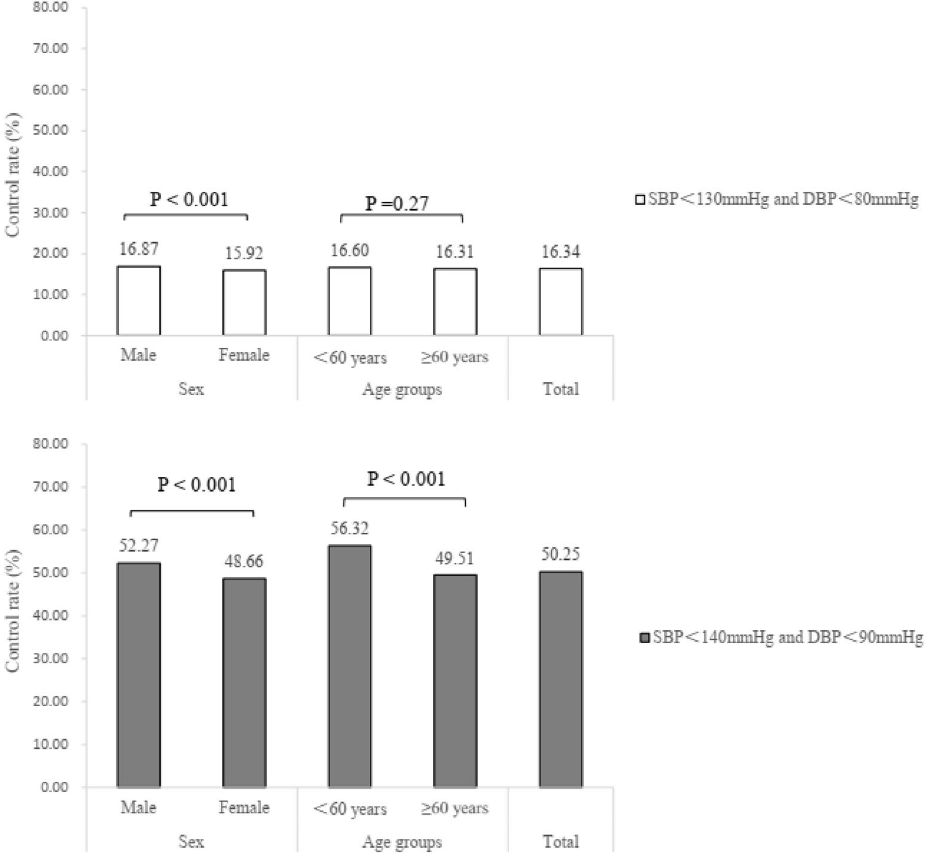
Figure 1. The BP control rate by different BP control